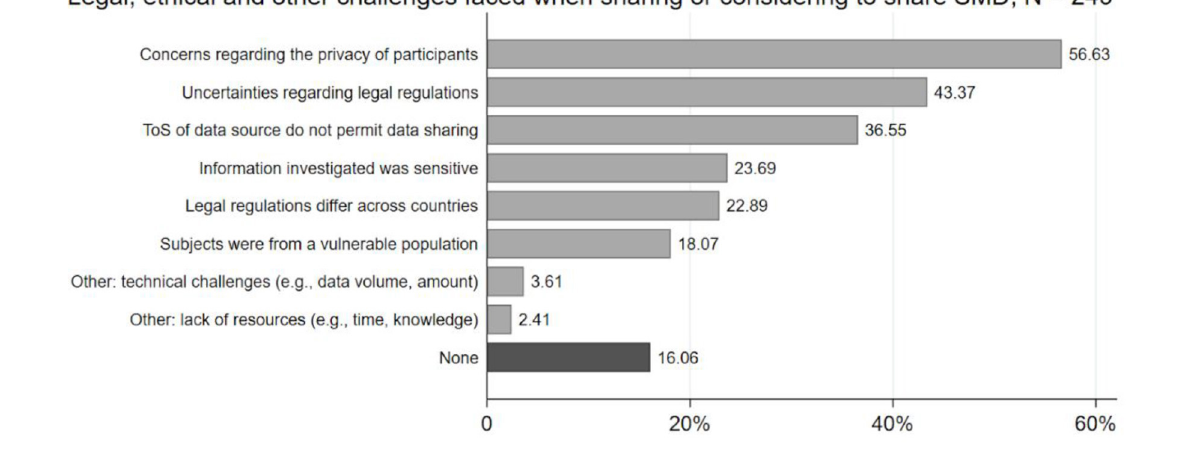
FIGURE2 Legal, ethical, and other challenges related to sharing SMD as experienced by researchers.